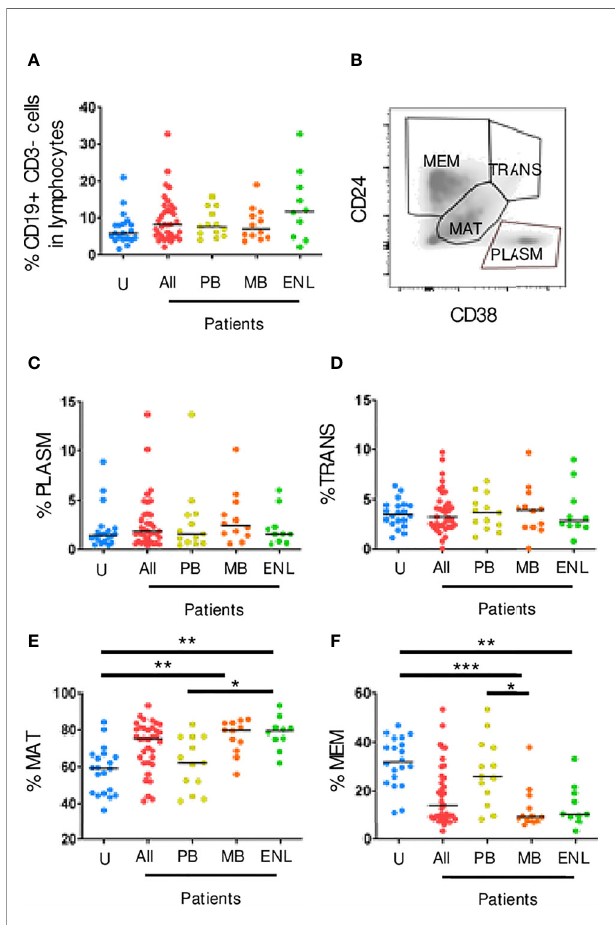
FIGURE 1 | Circulating CD19+ B cell subpopulations sorted by CD24 and CD38 expression. PBMC of uninfected individuals (U), paucibacillary patients (PB), multibacillary patients in type II reaction (ENL) or not (MB) were freshly stained and analyzed by fl ow cytometry. (A) Frequency of CD19+ CD3- B cells among lymphocytes for all groups described above in which All represents PB, MB, and ENL. (B) Density plot pro fi le for B cell subpopulations based on CD24 and CD38 expression in which memory B cells (MEM), transitional B cells (TRANS), mature B cells (MAT), and plasmablasts (PLASM) are depicted. Percentage of plasmablasts (C) , transitional B cells (D) , mature B cells (E) , and memory B cells (F) among CD19+ CD3- B cells. Each dot represents one donor and lines represent median values for each group. Signi fi cant values (*) were calculated by Kruskal-Wallis tests with Dunn ’ s multiple comparisons test. *p < 0.05; **p < 0.005; ***p <